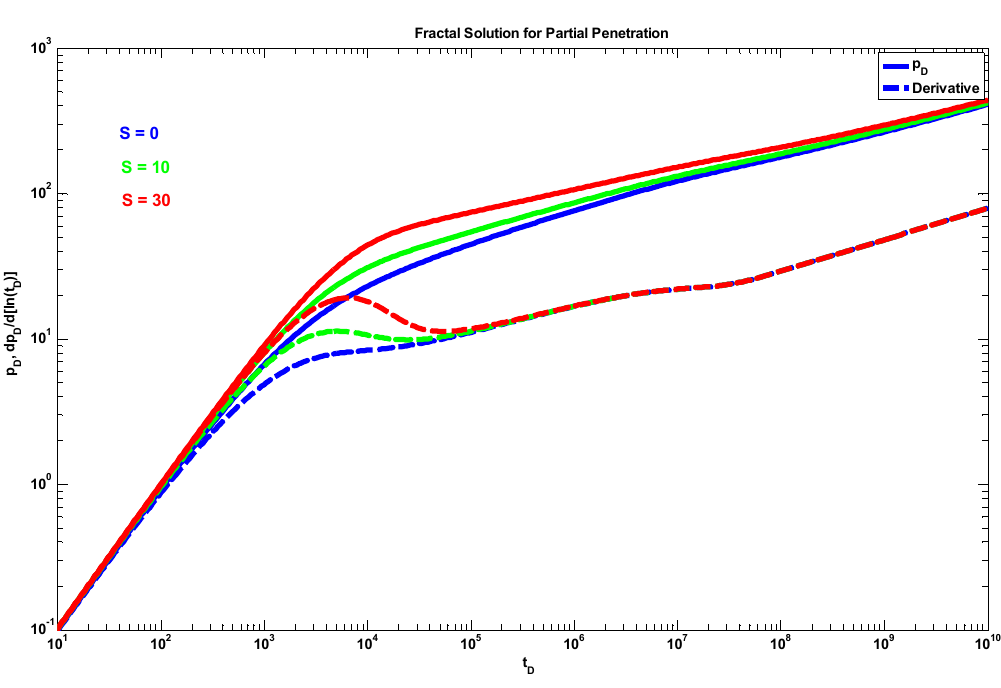
θ Fractal Fract. 2019 , 3 , 23 𝜃 (cid:3053) = 0 . z = 0.